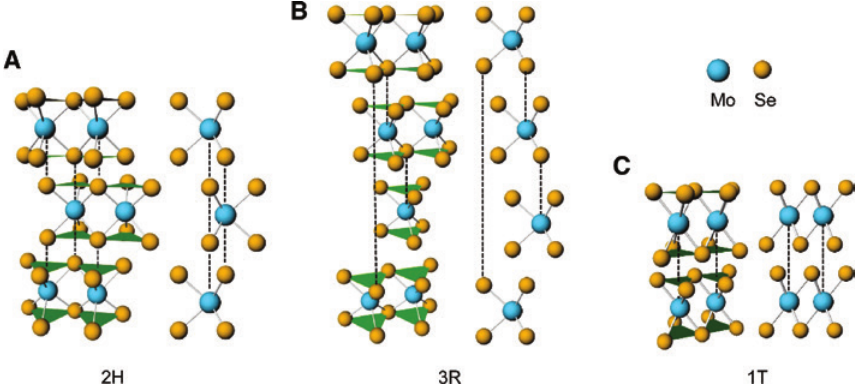
film: (A) 2H, (B) 3R, and (C) 1T. 2